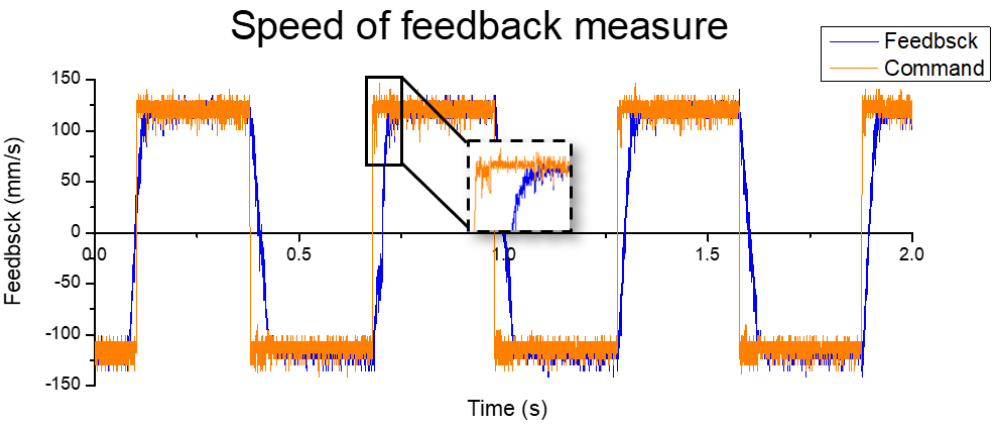
Figure 16. Position feedback measurement.